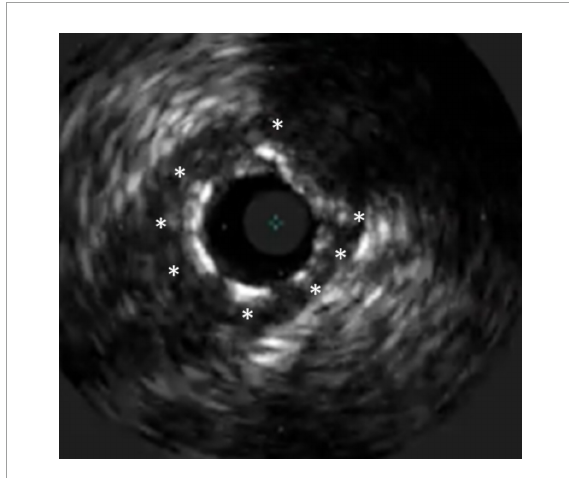
FIGURE9 Malapposition. Although not being a direct cause of restenosis, the flow disturbance caused by the malapposed struts may cause neointima proliferation distal to the